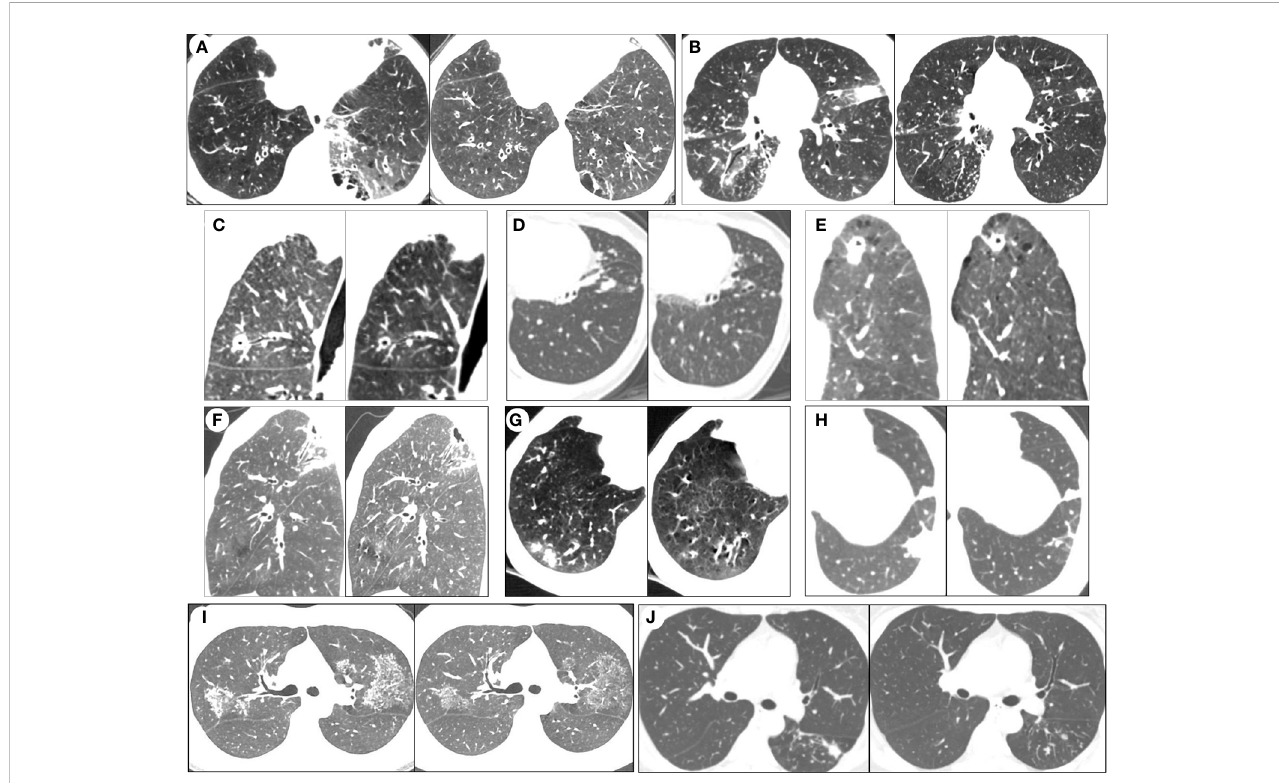
FIGURE 3 Serial chest computed tomography (CT) scans of selected patients with NTM-PD before and after the anti-NTM treatment. After 2 to 3 months of anti- NTM treatment, HRCT imaging showed signi fi cant absorption of lesions in patient 1 (A) , patient 2 (B) , patient 3 (C) , patient 4 (D) , patient 5 (E) , patient 6 (F) , patient 7 (G) , 464 patient 8 (H) , patient 9 (I) and patient 11 (J) .